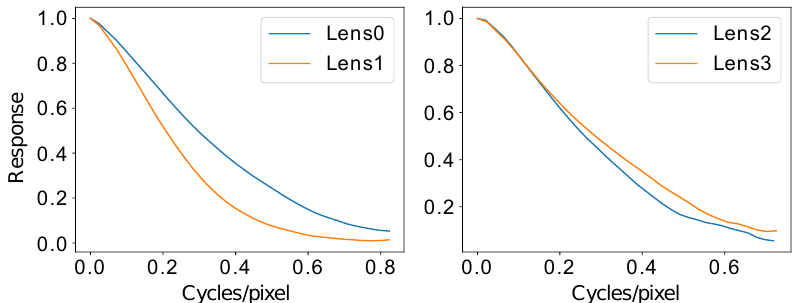
Figure 9. These two plots illustrate the MTF testing results at the same pixel positions for a sensor with two Lensagon lenses and two Pixoel lenses. Although the two lenses in each plot were the same model, their imaging capabilities were